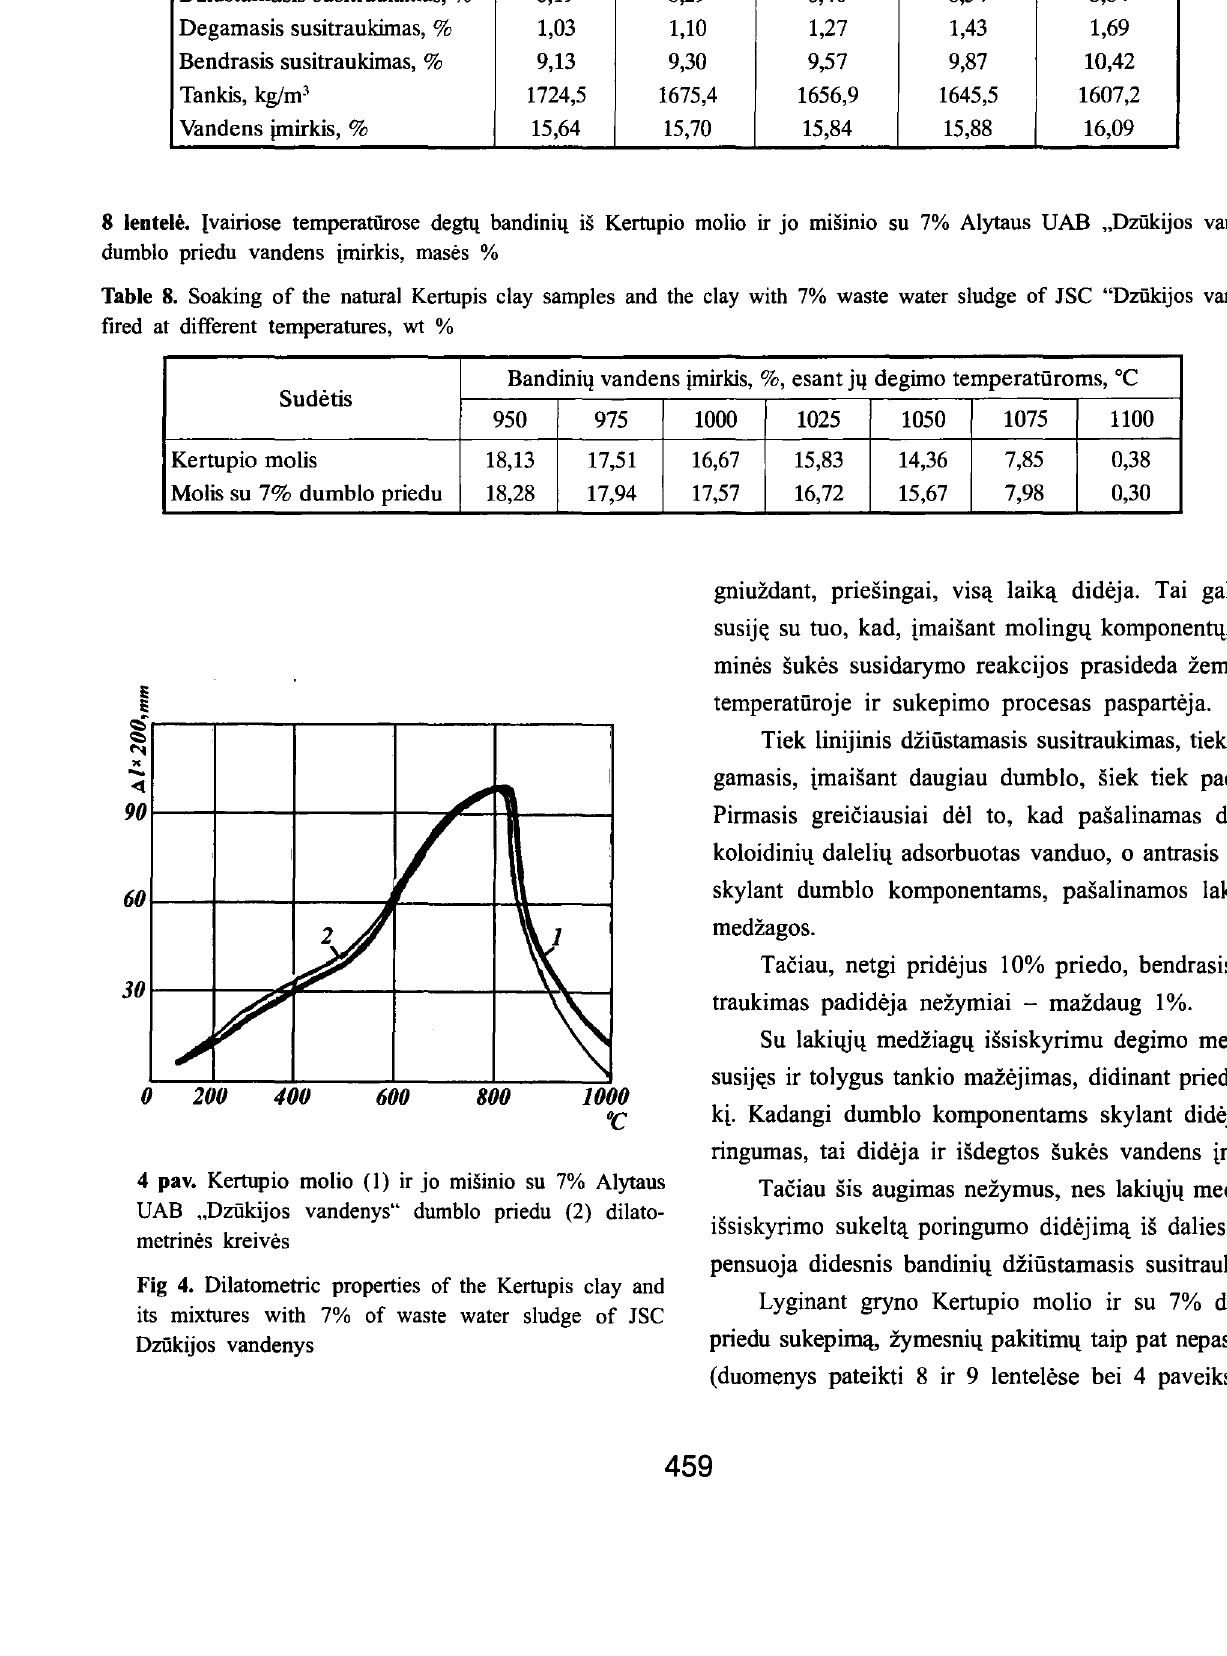
Table 8. Soaking of the natural Kertupis clay samples and the clay with 7% waste water sludge of JSC "Dziikijos vandenys" fired at different temperatures, wt %